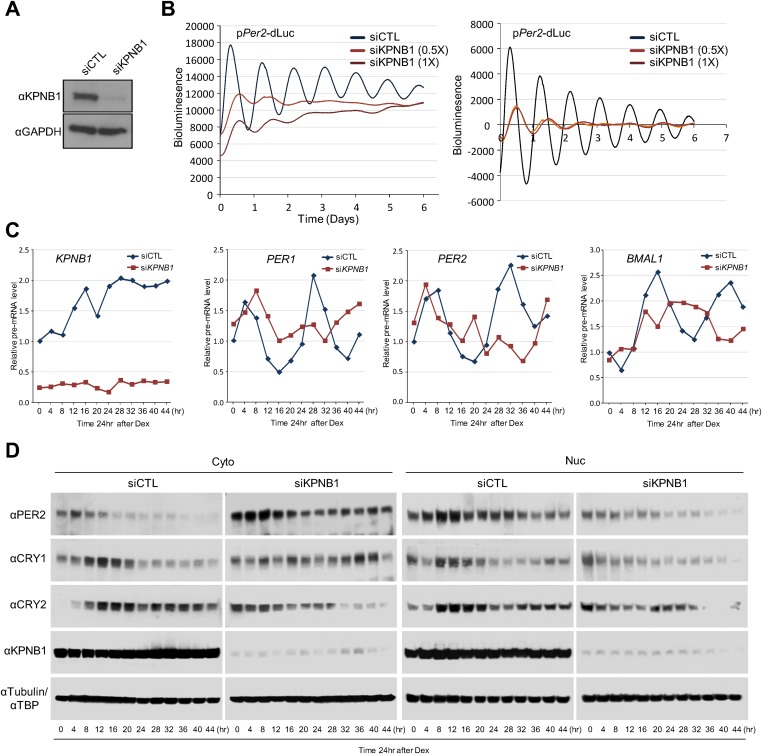
KPNB1 is required for circadian gene expression.(A) Immunoblot analysis of KPNB1 knockdown efficiency with anti-KPNB1 (αKPNB1) in control (siCTL) and KPNB1 siRNA (siKPNB1)-treated U2 OS cells. Anti-GAPDH antibody (αGAPDH) was used as a loading control. (B) Bioluminescence recordings of dexamethasone (Dex)-synchronized control (siCTL) and increasing dose of KPNB1 siRNA (siKPNB1 0.5×/1×)-treated U2 OS cells expressing Per2 promoter-driven destabilized luciferase (left; pPer2-dLuc). The Bioluminescence recordings were detrended by a 24-hr moving average subtraction (right). (C) Altered rhythmic expression of KPNB1, PER1, PER2, and CRY1 transcripts by KPNB1 depletion. mRNA expressions of the target genes were determined by quantitative RT-PCR in control or KPNB1-depleted U2 OS cells over the course of 44 hr after 24 hr upon Dex treatment. The data are shown with the mean value of triplicate samples in each time point. (D) KPNB1 knockdown alters rhythmic nuclear accumulation of PER and CRY proteins. Immunoblotting analysis using cytoplasmic and nuclear extracts prepared from control or KPNB1-depleted U2 OS cells collected at 4 hr interval over the course of 44 hr after 24 hr of Dex treatment. Anti-PER2, anti-CRY1, anti CRY2, and anti-KPNB1 antibodies were used for detecting endogenous PER2, CRY1, CRY2 and KPNB1 proteins. Anti-Tubulin antibody (αTubulin) for cytoplasmic fraction (Cyto) marker and anti-TATA binding protein (αTBP) for nuclear fraction (Nuc) marker were used for loading controls respectively. Representative images from two independent experiments are shown.